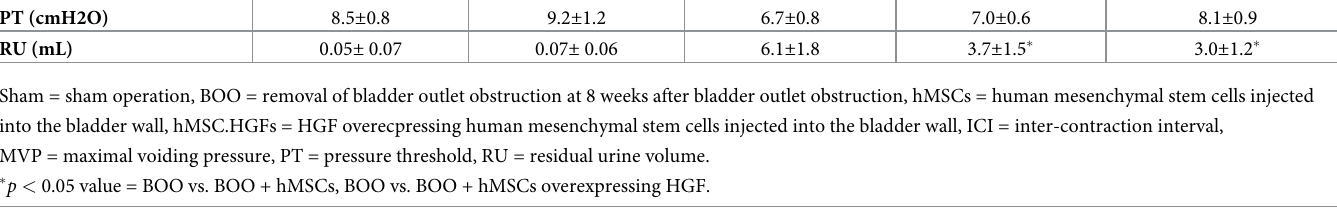
mRNA expression in the bladder of BOO group The level of collagen 1 mRNA expression was increased in the BOO group and decreased after transplantation of hMSCs. It was further decreased ( p < 0.05) after transplanting HGF-overex- pressing hMSCs. HGF mRNA expression was increased ( p < 0.05) after transplanting HGF- overexpressing hMSCs. The expression of TGF- β 1 mRNA was increased in the BOO group and decreased after transplanting hMSCs. It was further decreased ( p < 0.05) after transplant- ing HGF-overexpressing hMSCs (Fig 4).